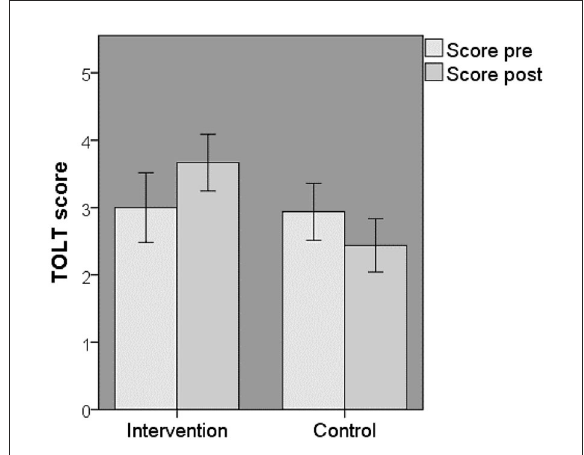
FIGURE3 TOLT scores for VWO students ± standard error. Shown are the pre- and post-TOLT scores for both the intervention and control VWO students. MAVO and VWO intervention